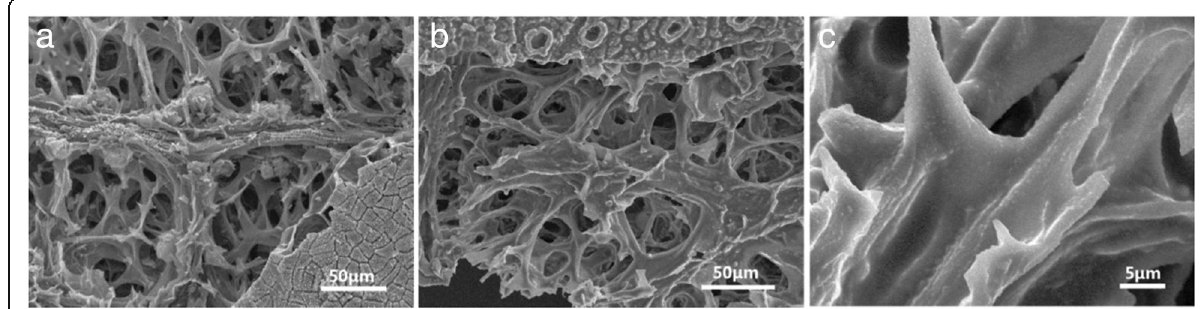
Fig. 7 SEM images of the Se-R800A electrode film a before and b after cycles. c Magnified SEM image of the carbon sheet after